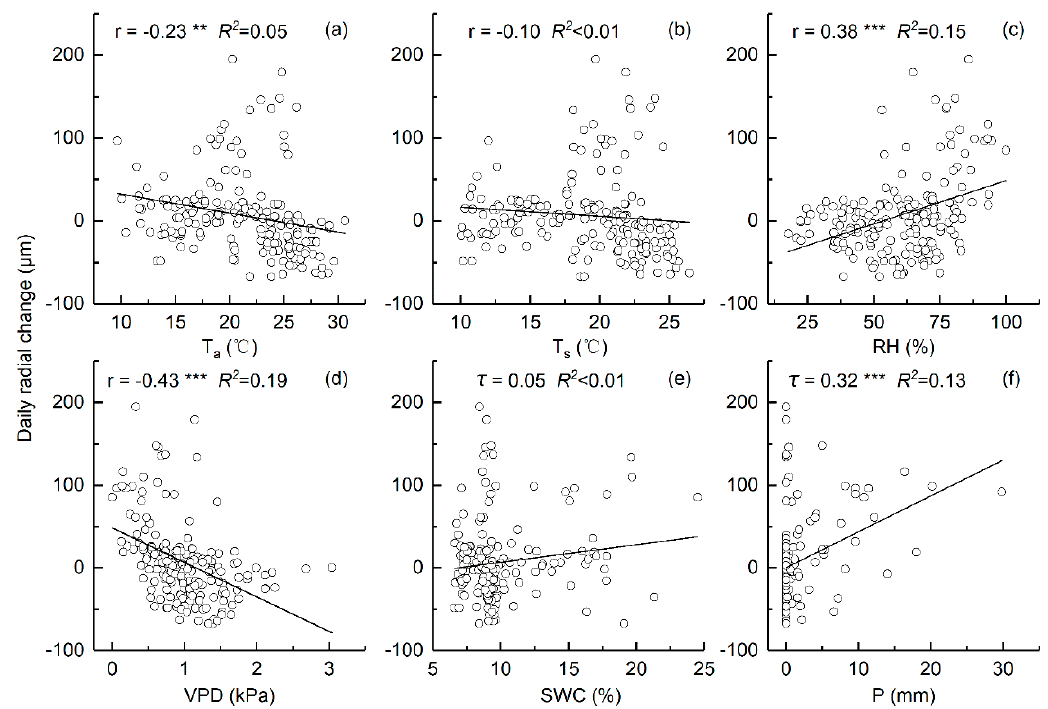
Figure 7. Correlations between DRC of P. orientalis and environmental factors of T a ( a ), T s ( b ), RH ( c ), VPD ( d ), SWC ( e ), and P ( f ) during growing season. Pearson correlation coefficient (r) and Kendall’s tau coefficient ( τ ) values are shown with *: p < 0.05, **: p < 0.01, ***: p < 0.001.